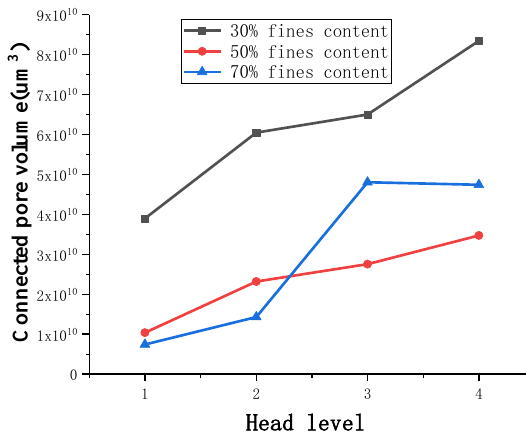
Figure 10. Total connected pore volume change.